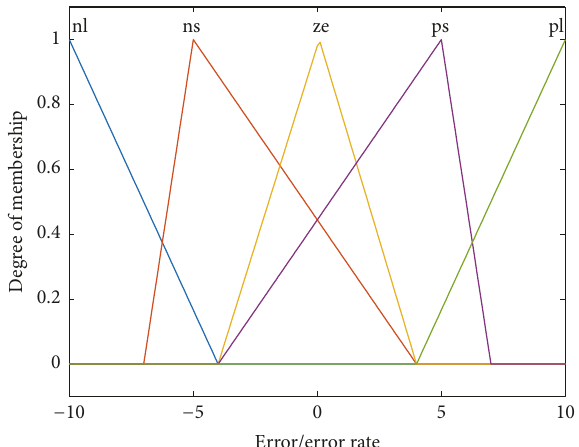
Figure 5: Membership functions designed for the